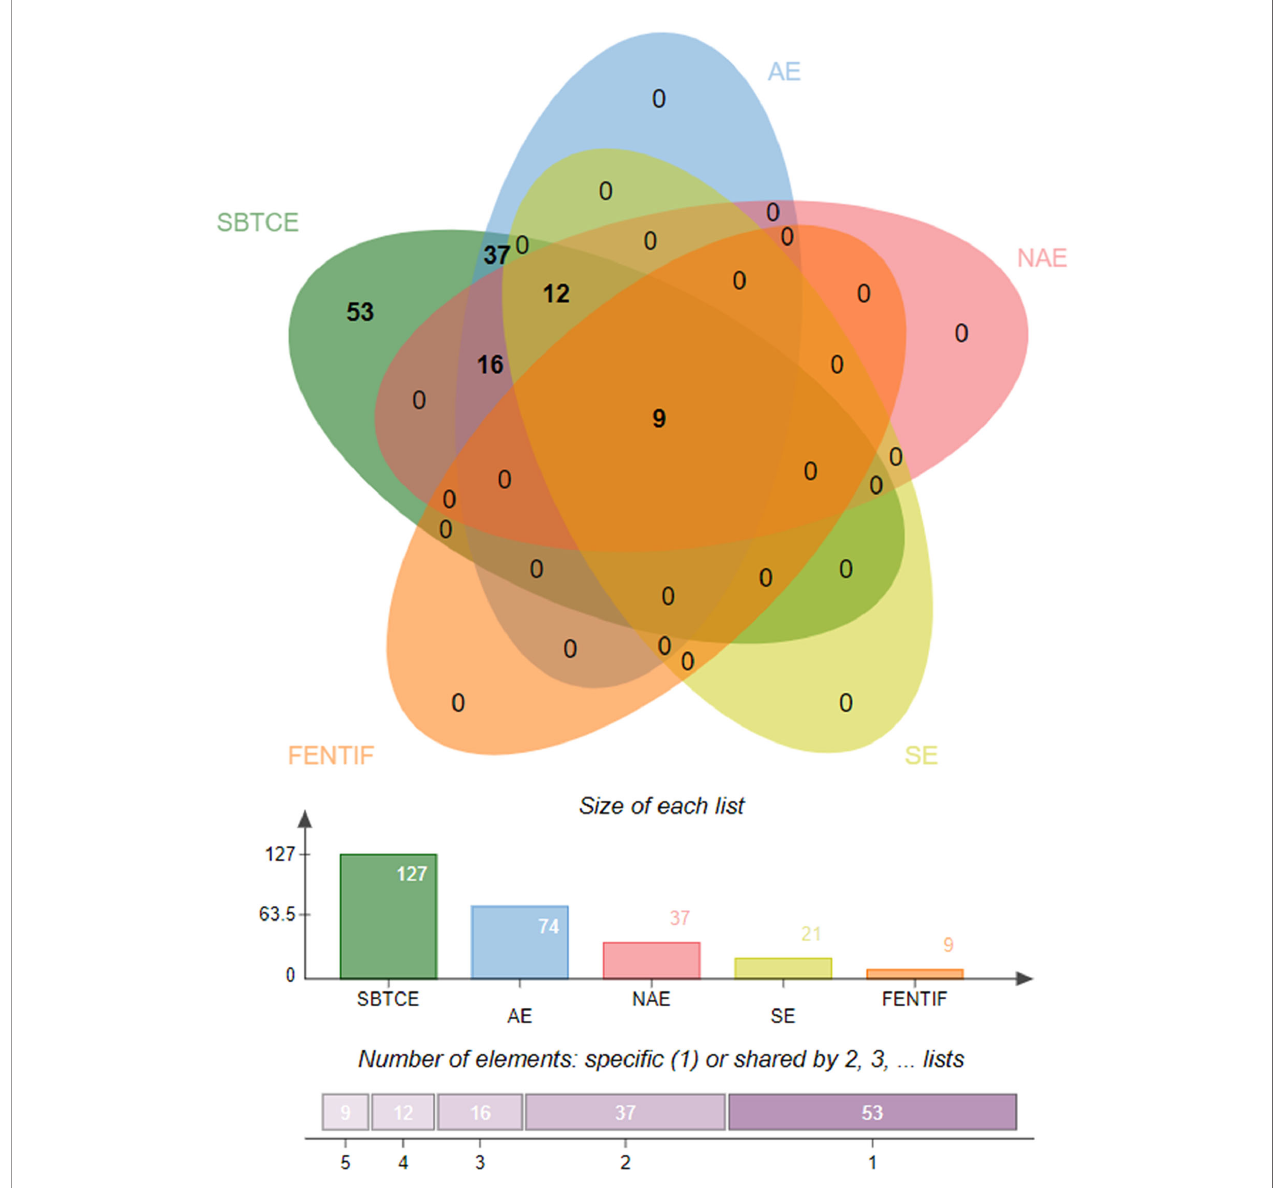
FIGURE 2 | Venn diagram presenting the number of epitopes fi ltered at different phases. SBTCE, Shared B and T cell epitopes; AE, Antigenic Epitopes; NAE, Non-Allergen Epitopes; SE, Soluble Epitopes; FENTIF, Final set of Epitopes Nontoxic and IFN gamma positive